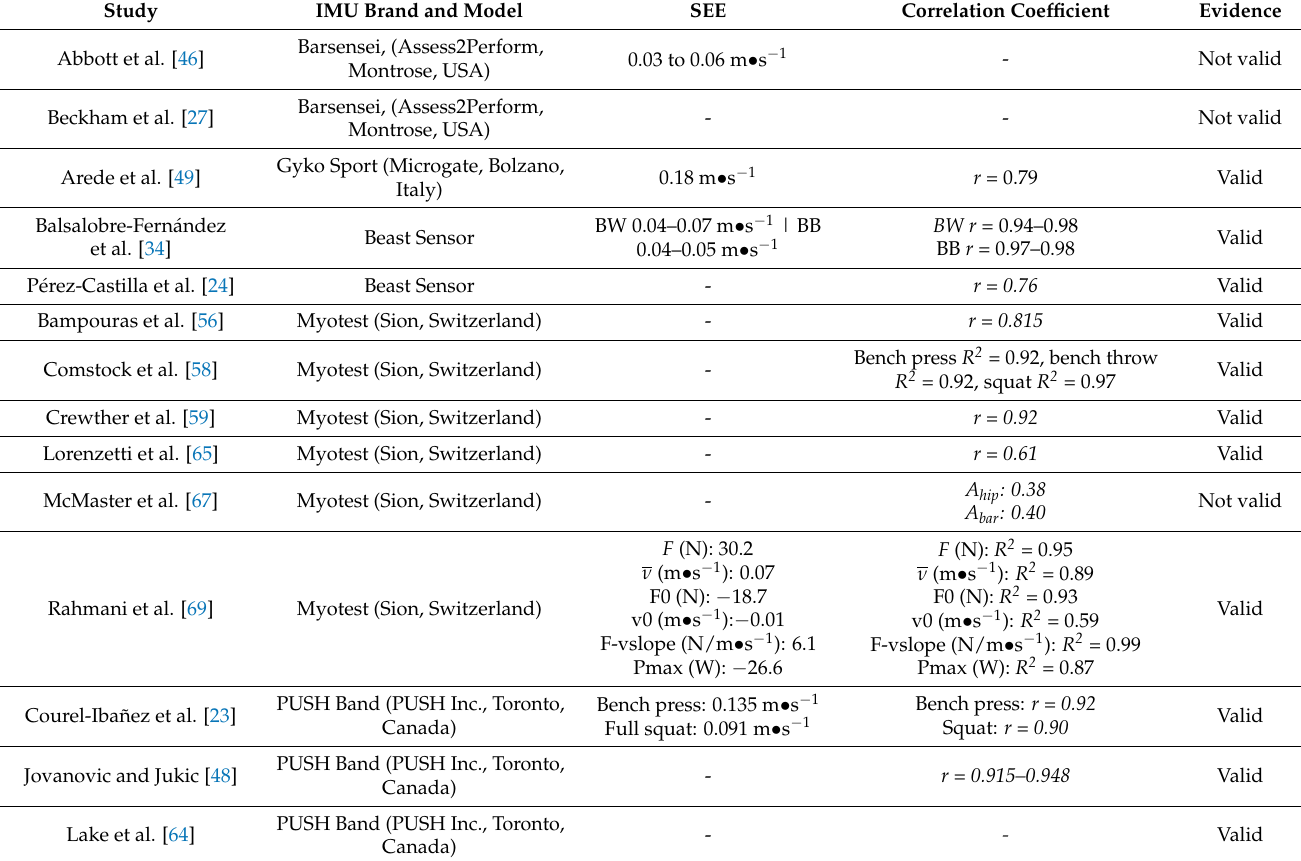
Table 4. Validity of IMU for estimation of barbell